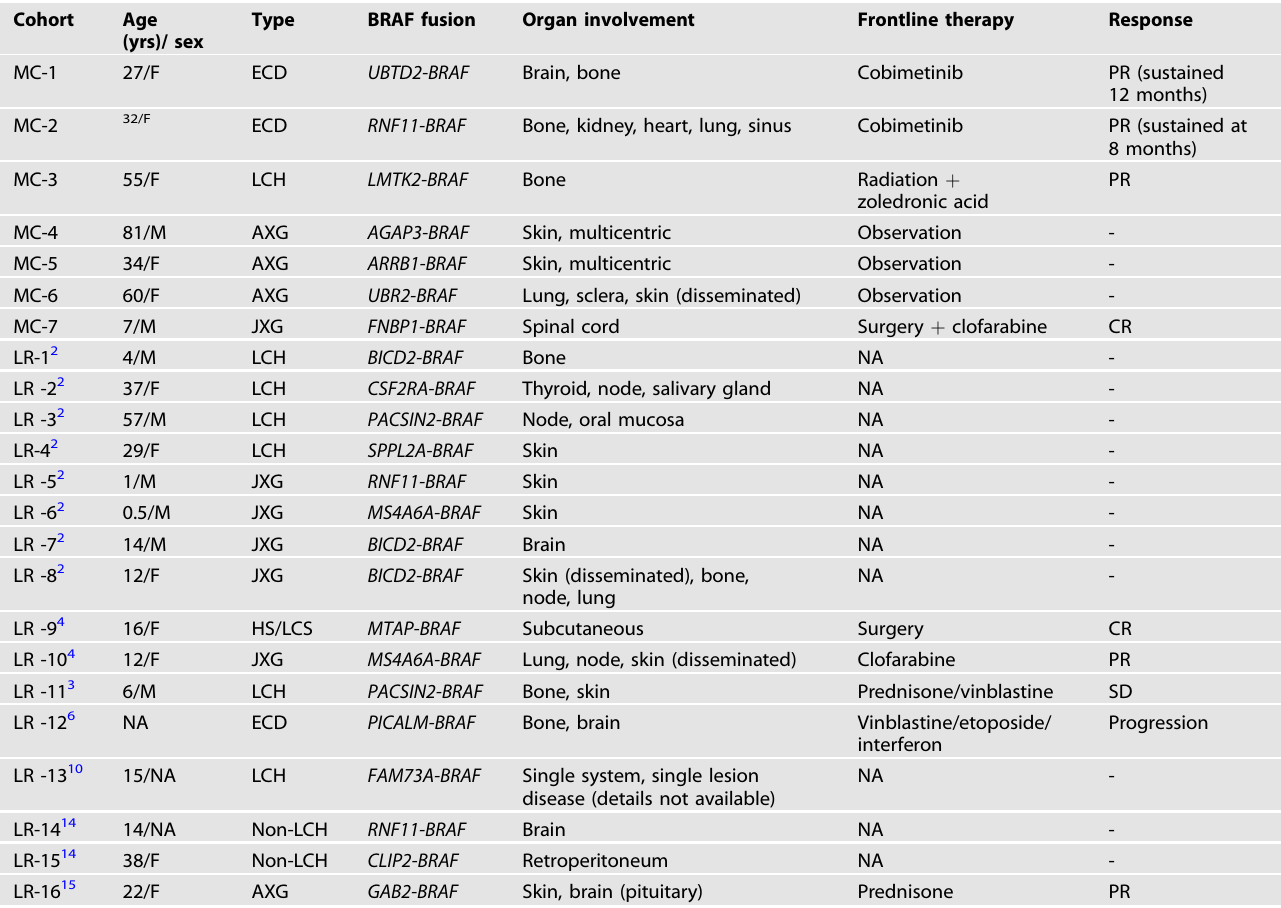
Table 1. Summary of clinical characteristics of patients with BRAF fusions in patients with histiocytic